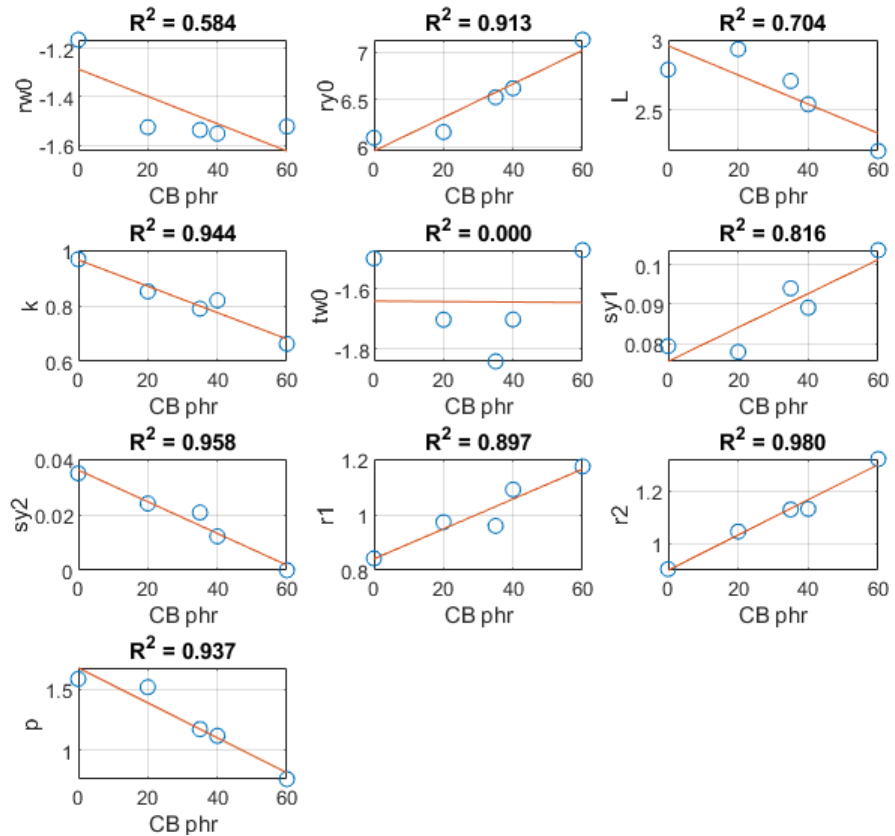
Figure 12. Correlations between the LBEM parameters and the CB